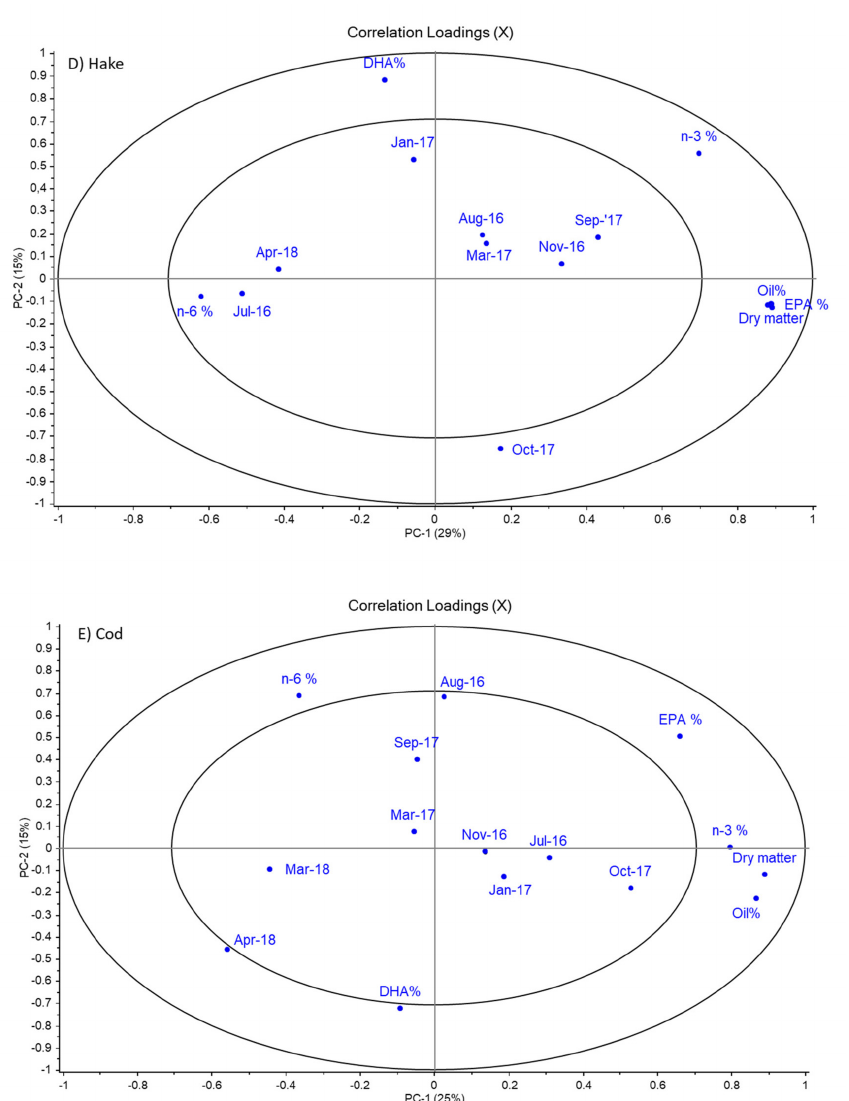
Figure 2. Individual PCA plots for all fish species, including specific sampling months and the data collected for dry matter content, oil content and fatty acid composition (n-6, n-3, EPA, DHA). Peroxide value and free fatty acids. Storage conditions are not included. Variables located within the inner ellipse explain less than 50% of the variation in the data. Variables located between the two ellipses explain between 50% and 100% of the variation in the